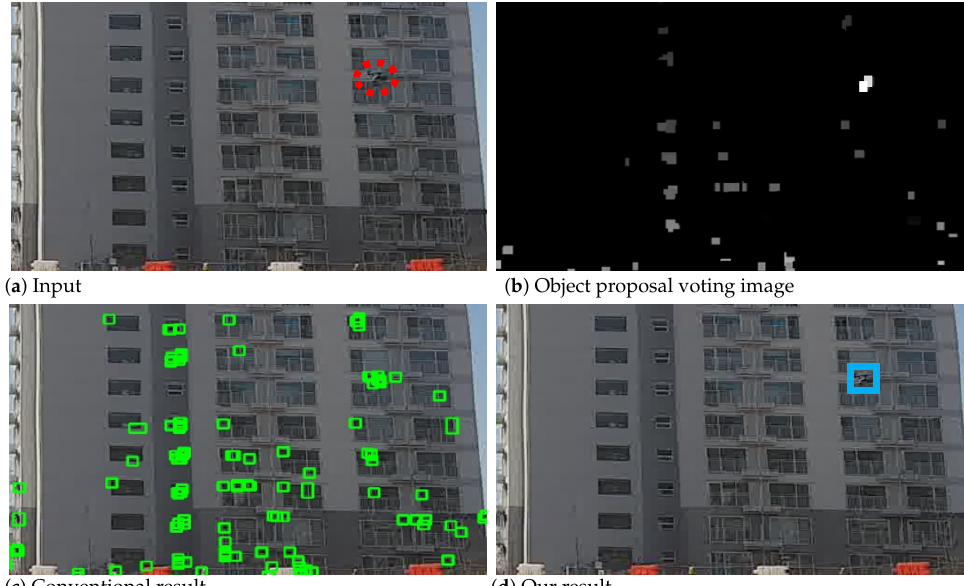
Figure 1. Basic concept of the proposed